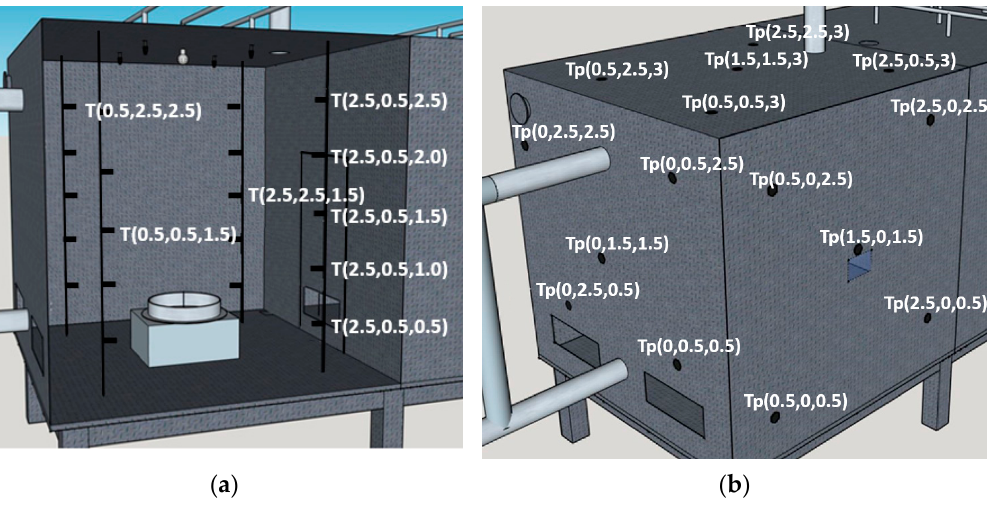
Figure 7. Schematics showing the locations of some thermocouples in compartment 1 to measure ( a ) gas and ( b ) wall temperatures. ( a ) gas and ( b ) wall temperatures.